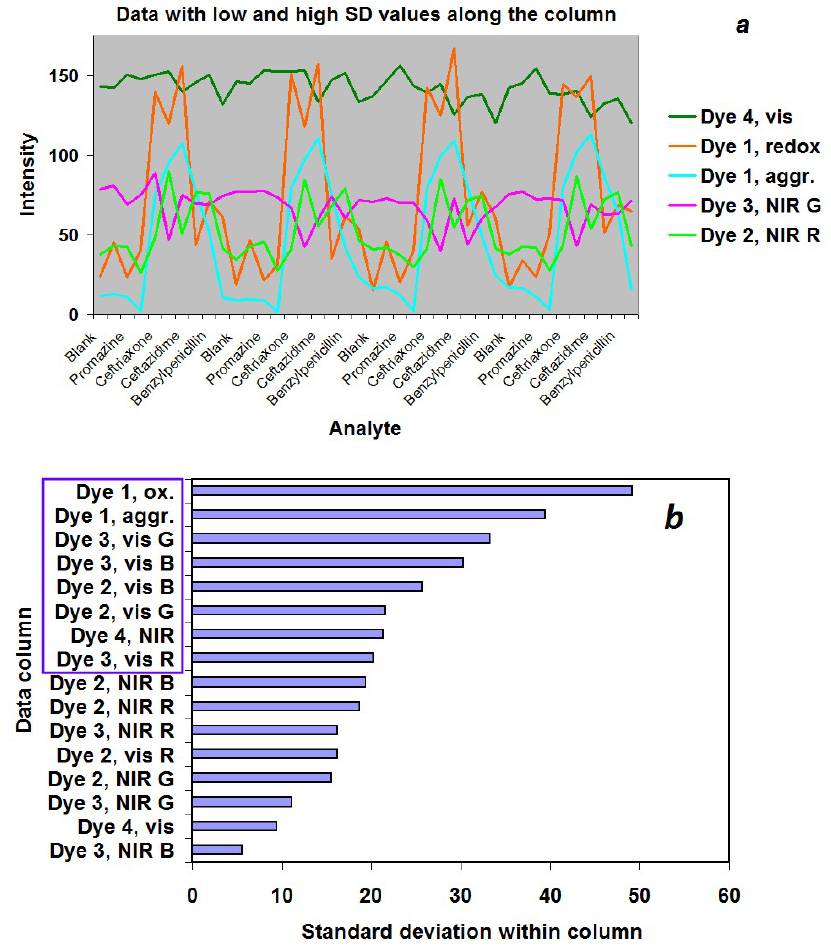
Figure 6. ( a ): Intensities of parallel runs with nine analytes for the selected indicator reactions of dyes 1 – 4 (shown in the legend). Only four analytes are made visible in the x- axis title to save space; ( b ): standard deviations of intensities for each column of the basic data set. The columns with higher ST DEV values selected for PCA treatment are framed.